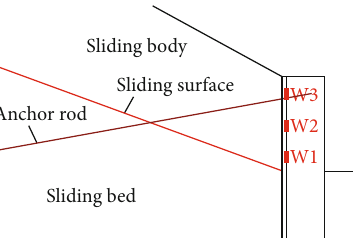
Figure 12: The monitoring points of dynamic earth pressure at